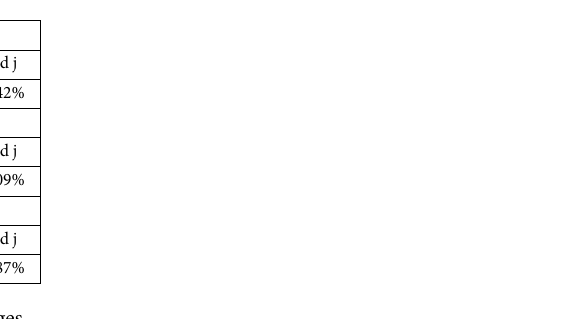
Table 4. Similarities between Four color